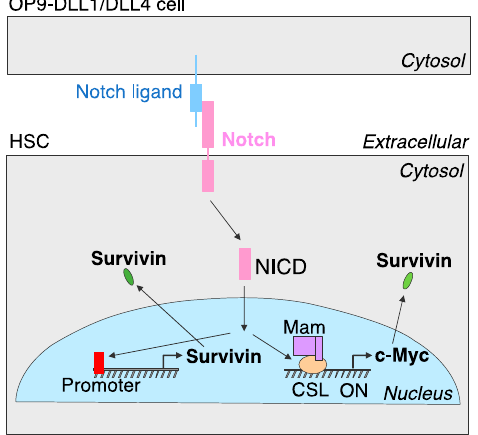
Figure 7. Model for Notch–c-Myc–survivin axis. The interaction between the Notch ligand and Notch receptor results in the transcriptionally active NICD, which translocates to the nucleus. In the nucleus, the NICD (i) interacts with CSL and Mam proteins, and induces transcription of c-Myc which subsequently regulates the expression of survivin involved in Notch-dependent T cell differentiation, and/or (ii) directly activates survivin by recognition of the survivin promoter region.